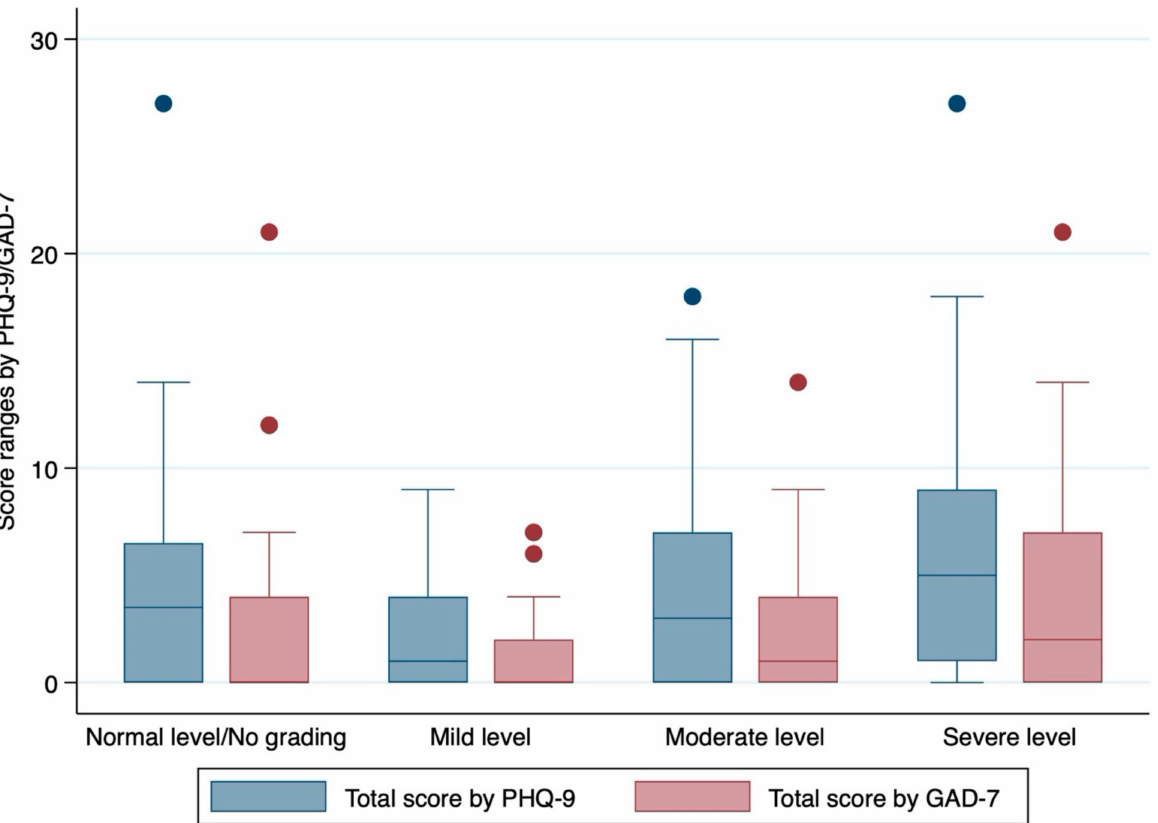
Figure 1. Measurement of total score by PHQ-9 and total score by GAD-7 according to the severity of COVID-19 patient who were treated by hospital health